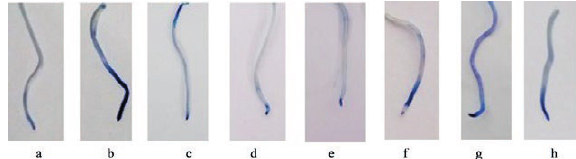
Figure 5. Analysis of apoptotic activity using Evans Blue stain- ing of root of A. cepa . a=control, b=30 ppm Ni, c=100 ppm Ea, d=100 ppm Ea, d= 250 ppm Ea, e=500 ppm Ea, f=30ppmNi+100 ppm Ea, g=30 ppm Ni+250 ppm Ea, h=30 ppm Ni+500 ppm Ea. Ea=encapsulated E. acoroides leaves extract.